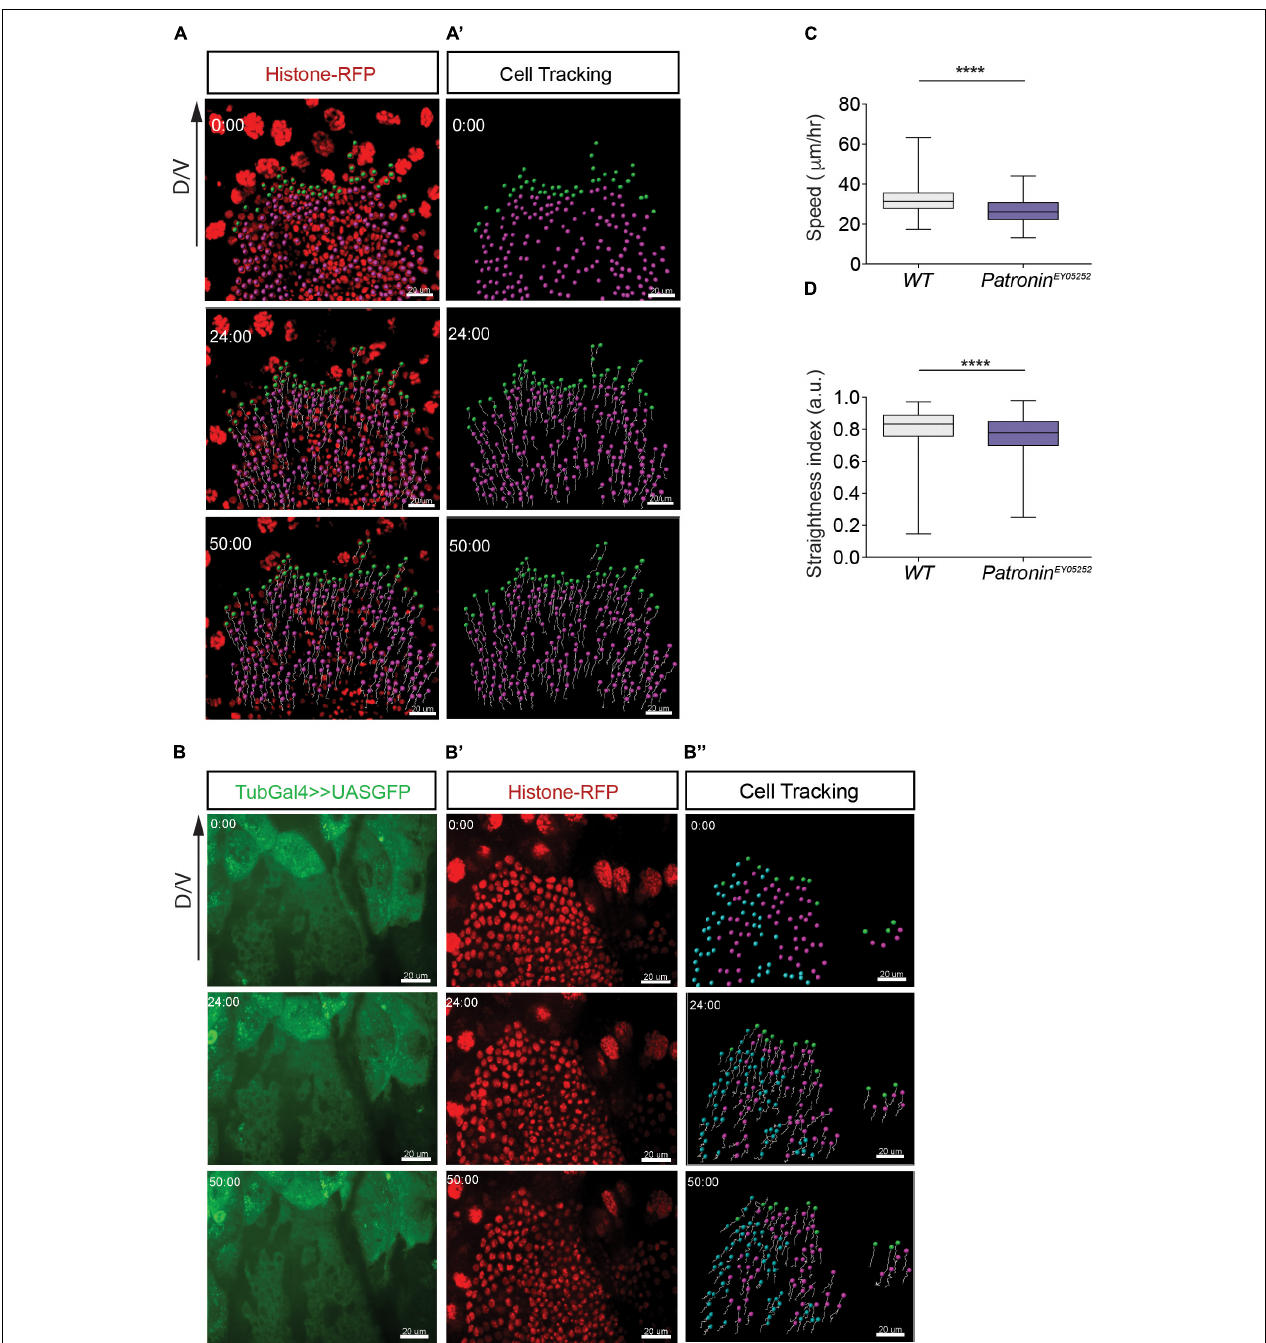
FIGURE 5 | Histoblast lacking Patronin show migration defects. (A) Representative images of migrating wild-type histoblasts in segment A3 expressing nuclear marker Histone-mRFP. (A’) The tracks are representative paths of the cells moving in the direction of migration axis. (B) Representative images of migrating patronin ey 05252 mutant histoblasts in segment A3 labeled with GFP and expressing nuclear marker Histone-mRFP (B’) . (B”) The tracks are representative paths of the wild-type cells (blue), patronin ey 05252 mutant cells (magenta) and leading cells (green) moving in the direction of migration axis. The panels (A–B”) represent snapshots of histoblast from 0 to 50 min during cell migration. Scale bars, 20 µ m. (C) Quantification of speeds for wild-type and patronin ey 05252 mutant histoblasts. Mann–Whitney U -tests, p < 0.0001 (****), number of cells ( n ) = 1,649, and pupae ( N ) = 3 for wild-type cells and number of cells ( n ) = 1,139 and pupae ( N ) = 5 for patronin ey 05252 mutant tissue. (D) The straightness index indicates the persistence of migration for wild-type and patronin ey 05252 mutant histoblasts. Mann–Whitney U -tests, p < 0.0001 (****), number of cells ( n ) = 1,649, and pupae ( N ) = 3 for wild-type and number of cells ( n ) = 1,139 and pupae ( N ) = 5 for patronin ey 05252 mutant tissue. Graphs in panels (C,D) show box plots with a line indicating the mean and maximum and minimum values. Developmental stage (B–C) : 24–29 h APF. Scale bars, 10 µ m.